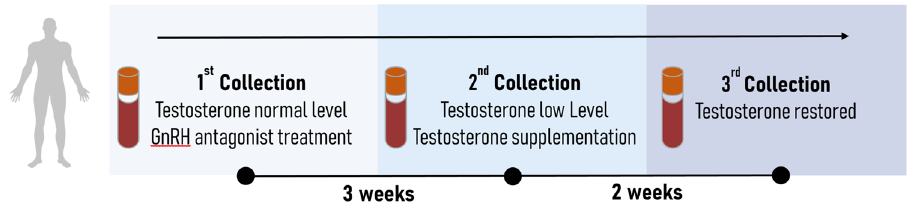
Figure 1. Schematic representation of the designed human model. Blood samples were collected three times. The first collection was done before any pharmacological treatment and represents testosterone and gonadotropins at baseline levels. During the same visit, after blood collection, all subjects received a subcutaneous injection of gonadotropin-releasing hormone antagonist (GnRHa, 240 mg, Degarelix, Ferring Pharmaceuticals, Sweden). Three weeks later, subjects’ blood samples were collected again, corresponding to low testosterone and gonadotropin levels. All participants then received an intramuscular injection of testosterone undecanoate (1000 mg, Nebido, Bayer Pharmaceuticals, Germany). After two weeks, the last blood samples were collected, corresponding to testosterone restored samples and low gonadotropin